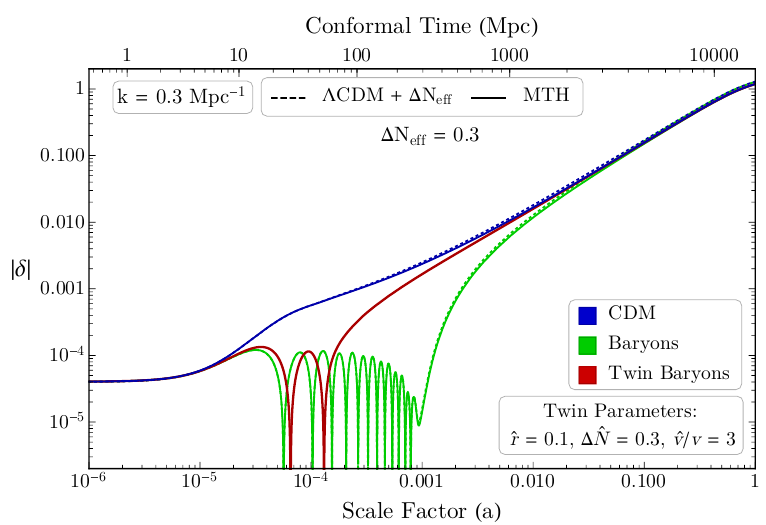
Figure 5. An example of the linear evolution of density perturbations of CDM, baryons, and twin baryons for Λ CDM + ∆ N (dashed) and the MTH model eff